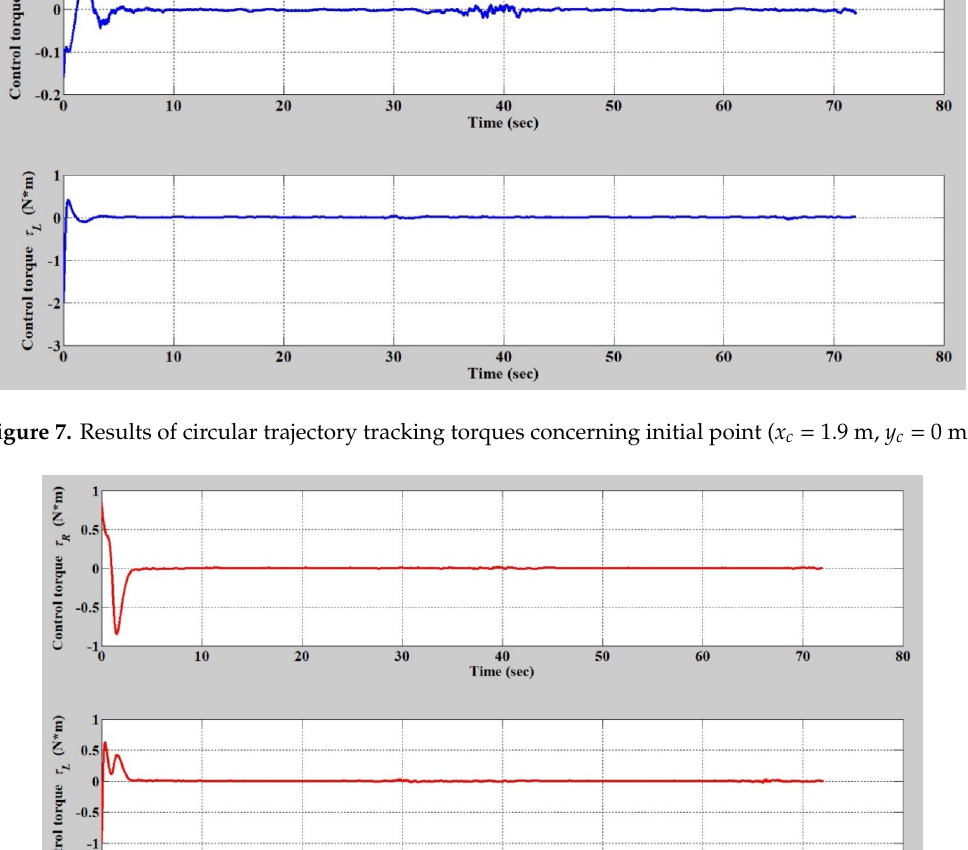
Figure 8. Results of circular trajectory tracking torques concerning initial point ( x c = − 1.9 m, y c = 0 m).